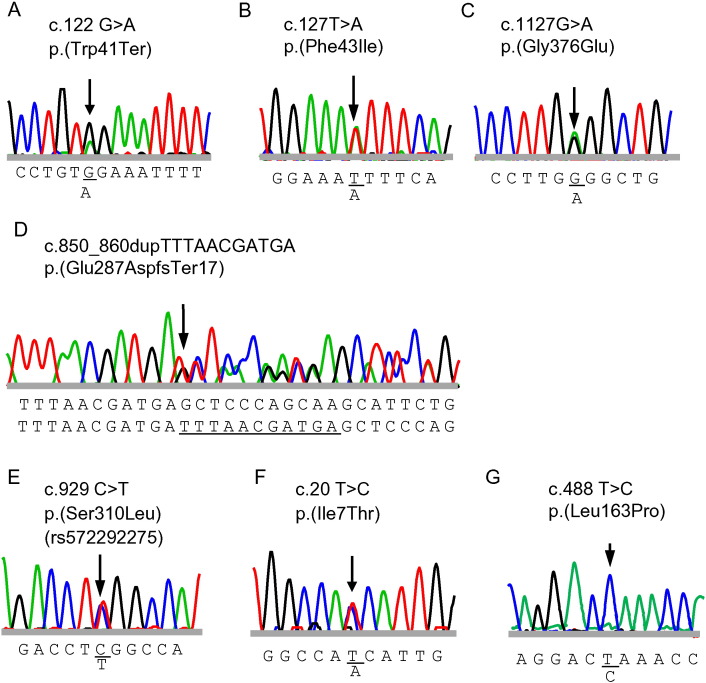
Nucleotide sequences of variant FMO3. Both strands were sequenced. The sequences are shown only for sense strands of genomic DNA from probands 1 (A), 2 and 3 (B), 2 and 4 (C), 5 (D), 6 (E), 7 (F), and 8 (G). The sequence of the complete human FMO3 gene described in GenBank (Accession Number AL021026) was used as the reference.